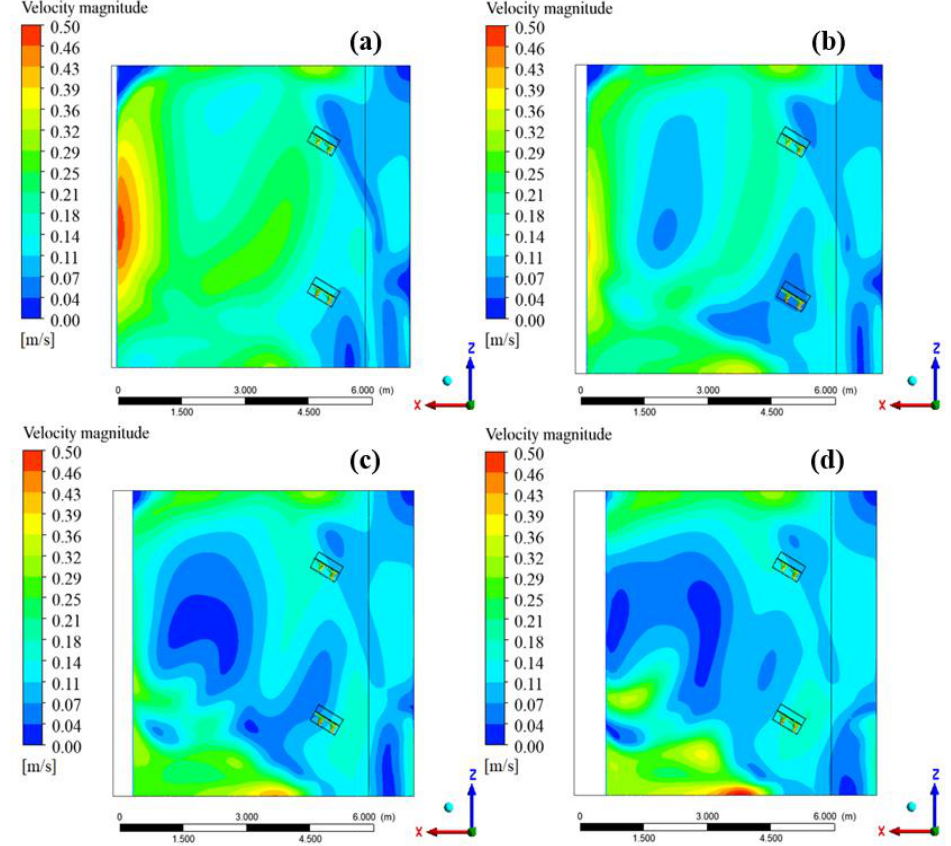
Figure 16. Velocity distribution contours for four horizontal profiles when the fan swing angle was 60°: plane 1 — 0.7 m ( a ), plane 2 — 1.0 m ( b ), plane 3 — 1.3 m ( c ), and plane 4 — 1.6 m ( d ). Table 4. Summary of the coefficients of variation of horizontal velocity profile for different fan heights. Emulated